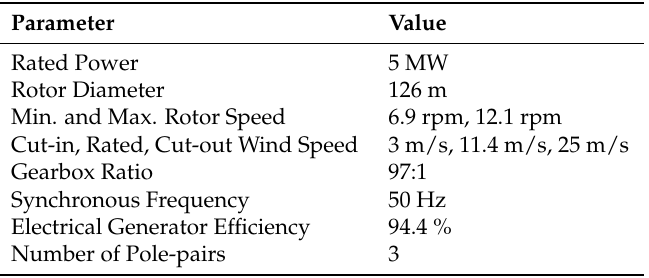
Table 1. Parameters of NREL 5-MW wind